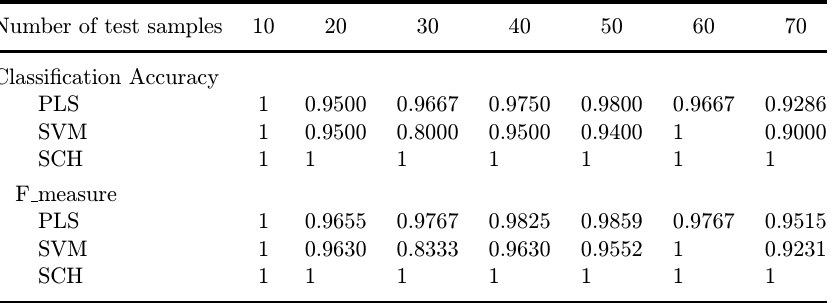
Table 2. Classi¯cation accuracy table for di®erent drugs